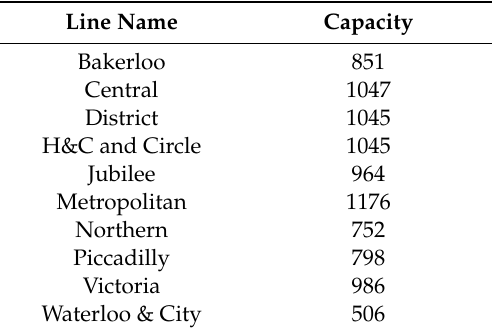
Table A1. LU train capacity per line as of